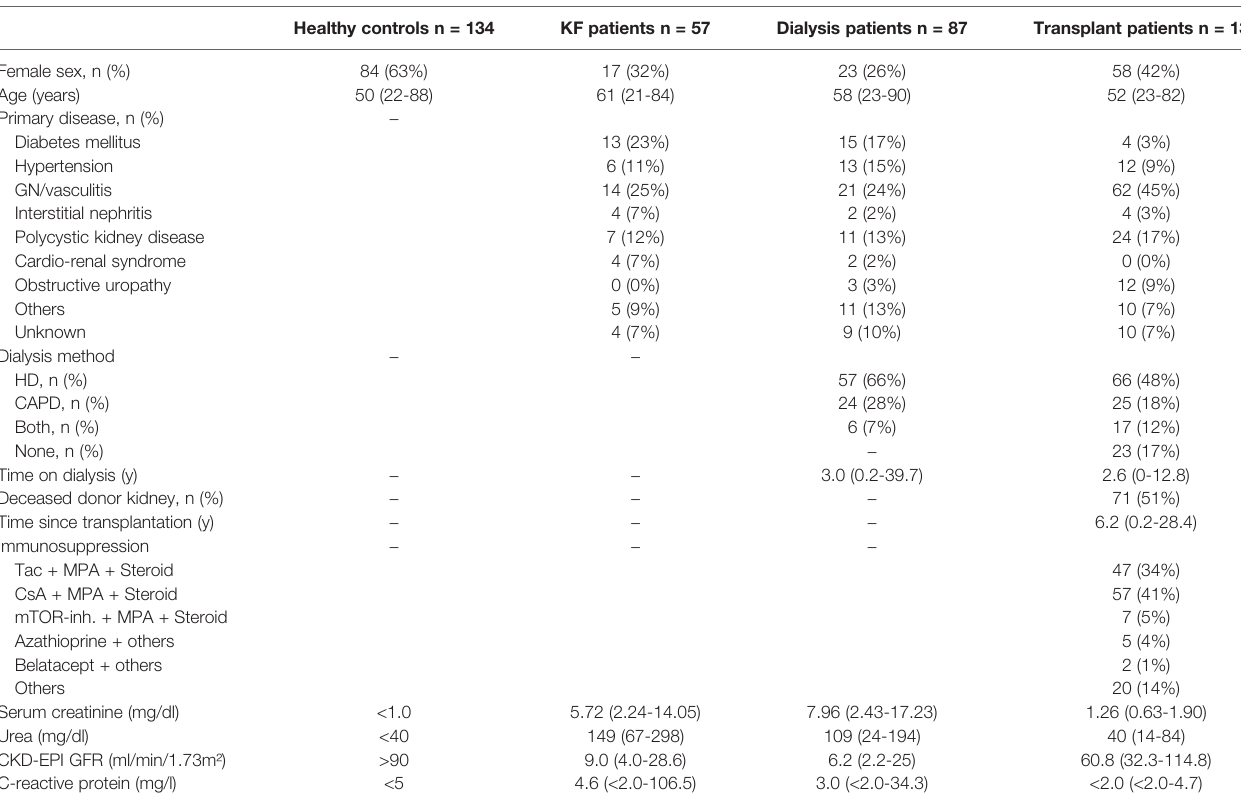
TABLE 1 | Clinical characteristics of the study